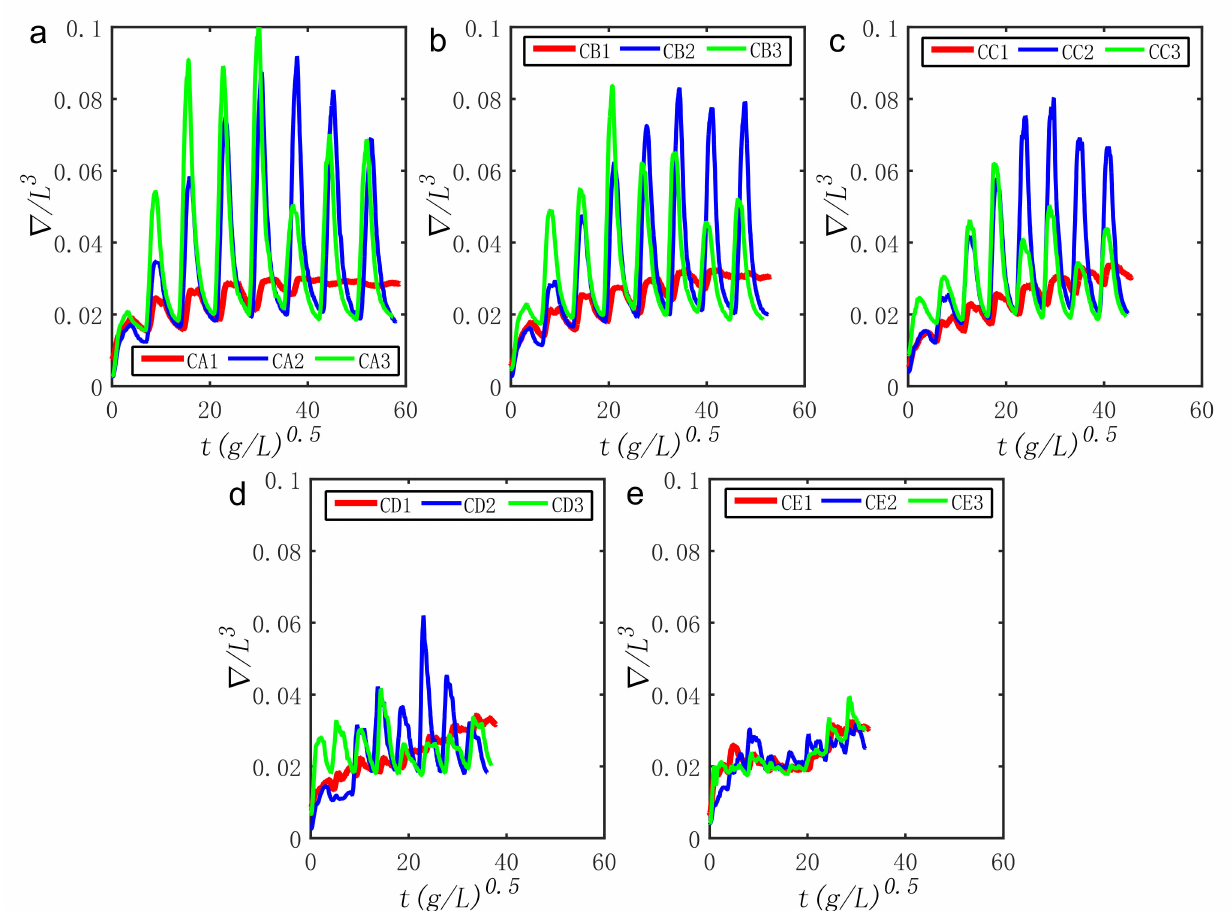
Figure 12. Time series of non-dimensional water volumes over the deck ( ∇ * = ∇ /L 3 ) for all the study cases. ( a ) Comparison between CA1, CA2, and CA3. ( b ) Comparison between CB1, CB2, and CB3. ( c ) Comparison between CC1, CC2, and CC3. ( d ) Comparison between CD1, CD2, and CD3. ( e ) Comparison between CE1, CE2, and CE3. L = 0.3 m, g = 9.81 m/s 2 .